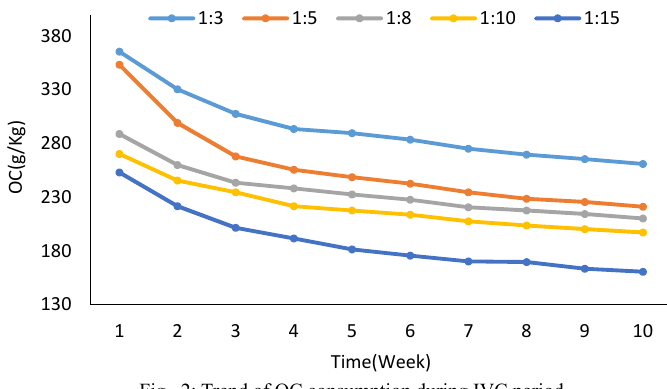
Fig. 2: Trend of OC consumption during IVC period